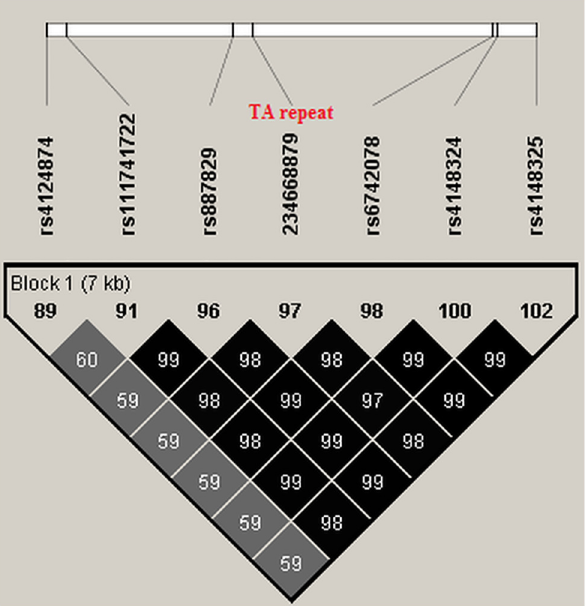
Fig 2. The LD structure between markers in peak association signals. r2 = correlation coefficient as a measure of linkage disequilibrium.